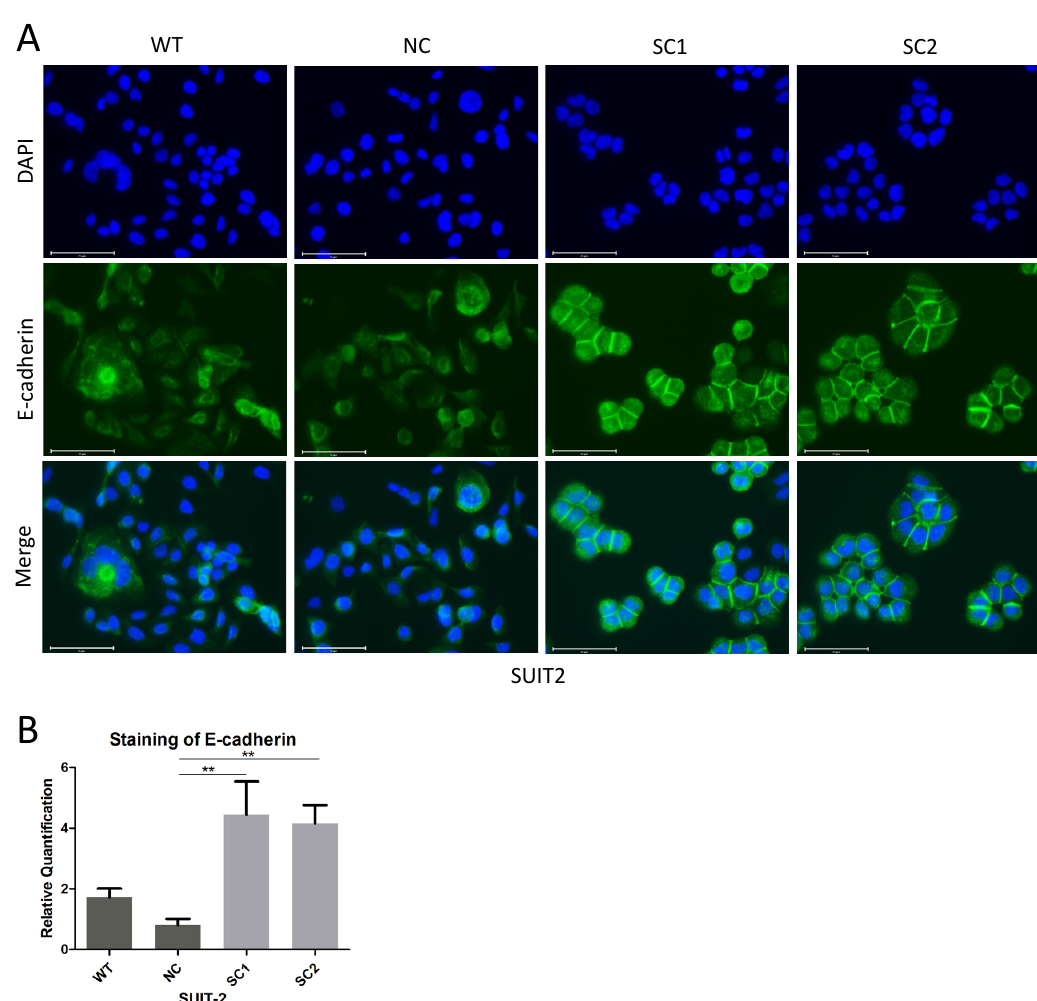
Figure 5. Knockout of PCSK6 induced the redistribution of E-cadherin at cell–cell junctions. ( A ) Im- munofluorescence staining of E-cadherin (green), DAPI (blue), and merge in SUIT-SCs and controls. Scale bar = 75 µ m. Diffuse and strong staining of E-cadherin was found at cell–cell gaps in sin- gle clones of SUIT-2, whereas scattered and weak staining of E-cadherin was found in WT or NC. ( B ) Relative quantification of E-cadherin staining at cell–cell junctions in SUIT-SCs and controls. SC1 = 4.4453 ± 1.0974, SC2 = 4.1570 ± 0.6033, WT = 1.7237 ± 0.2899, NC = 0.8093 ± 0.2007 (WT vs. NC p = 0.446, NC vs. SC1 p = 0.001, NC vs. SC2 p =